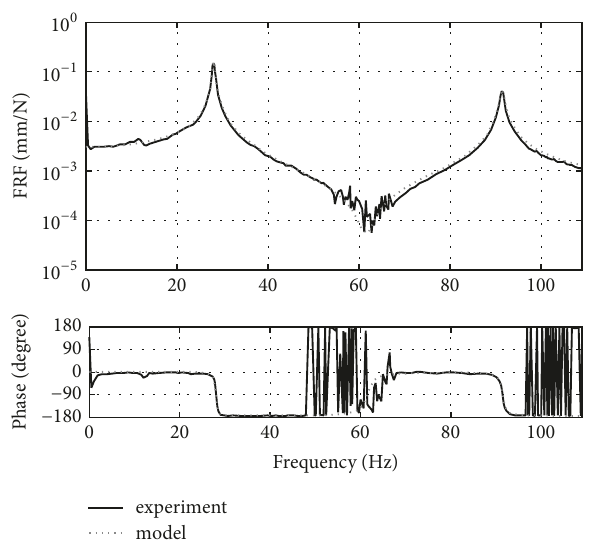
Figure 2: FRF obtained at node #8 of the FE model with excitation on node #13 and the corresponding experimental result [14].